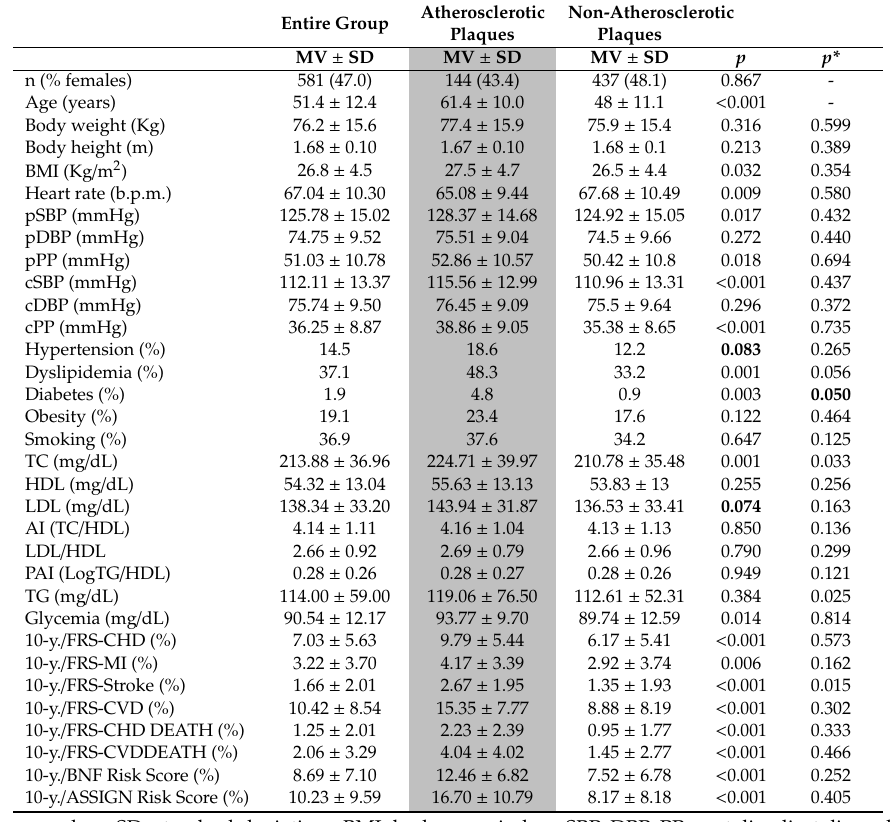
Table 1. Characteristics: groups comparison before and after